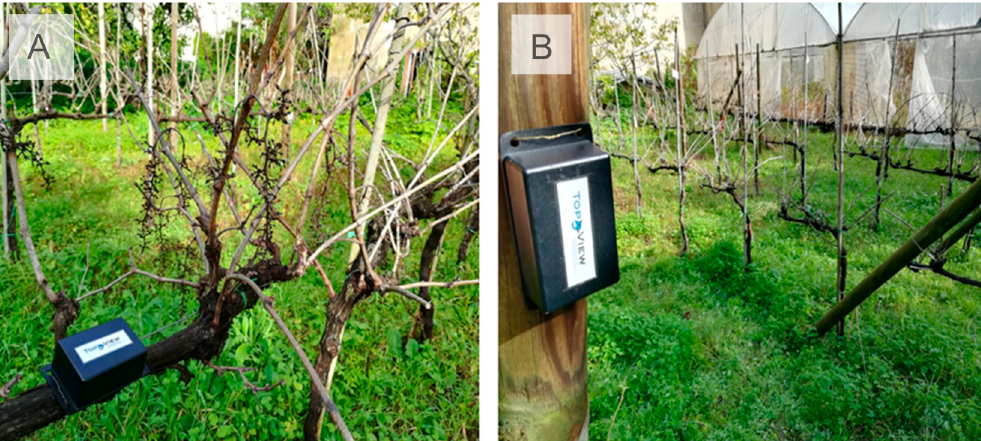
Figure 7. Pictures of AgriLogger in the vineyard: ( A ) inside canopy, ( B ) outside canopy. The pictures were taken in the winter to clarify the position of the sensor inside the canopy without leaf